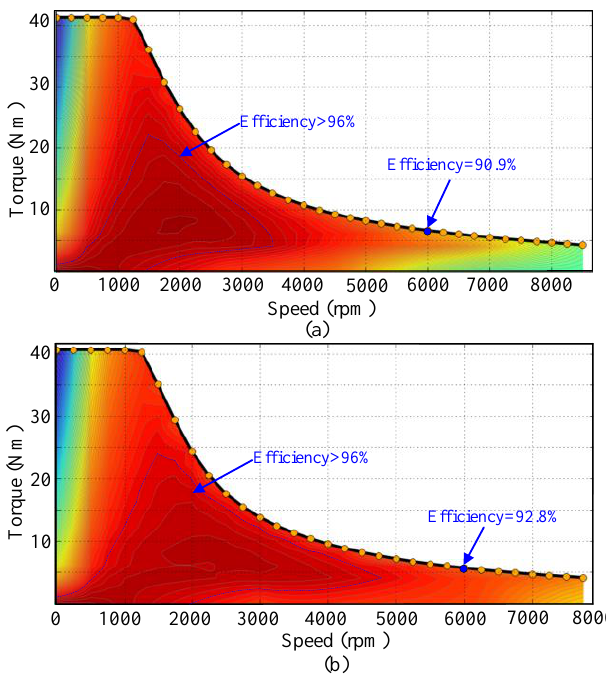
Figure 14. E ffi ciency characteristics by FEA: ( a ) the e ffi ciency map of the initial machine; ( b ) the e ffi ciency of the optimal